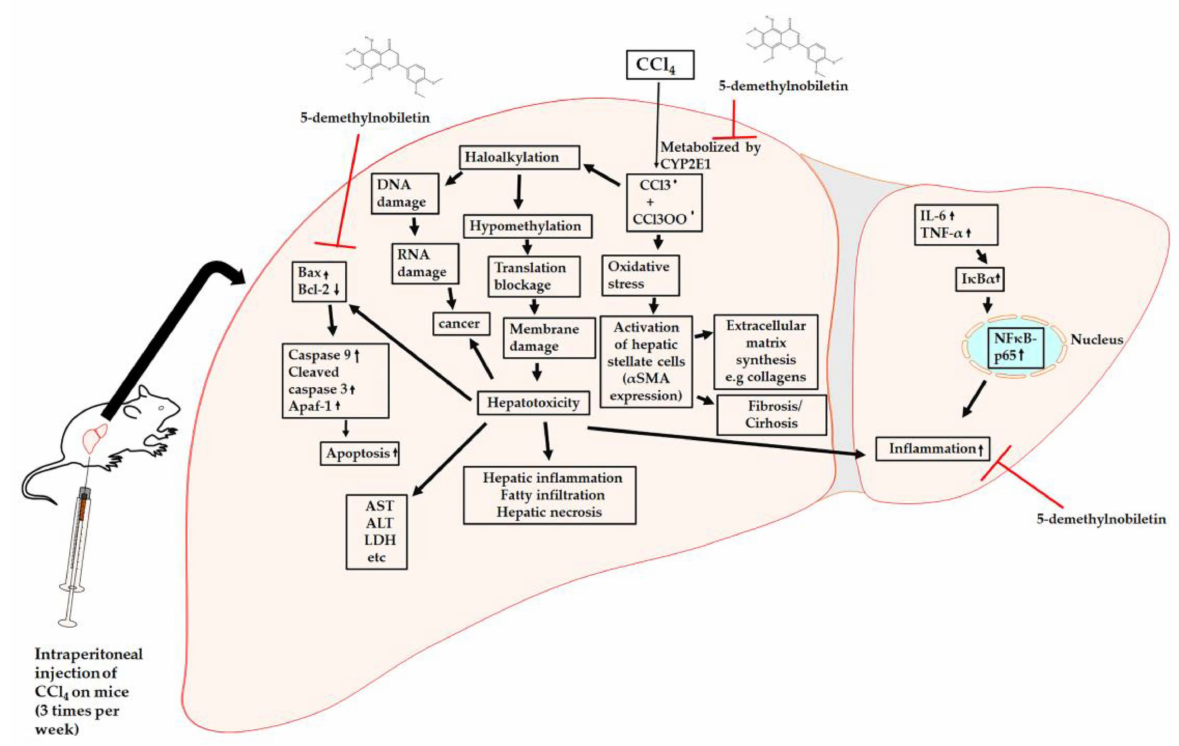
Figure 8. Role of 5-DN in counteracting CCl4-induced acute liver injury. ( ↑ ): represents upregulation of the spe-cific marker in response to CCl4 or 5-DN. ( ↓ ): represents downregulation of the specific marker in response to CCl4 or 5-DN. ( ┴ ): represents inhibition after treatment with 5-DN.Supplementary Materials: The following are available online at